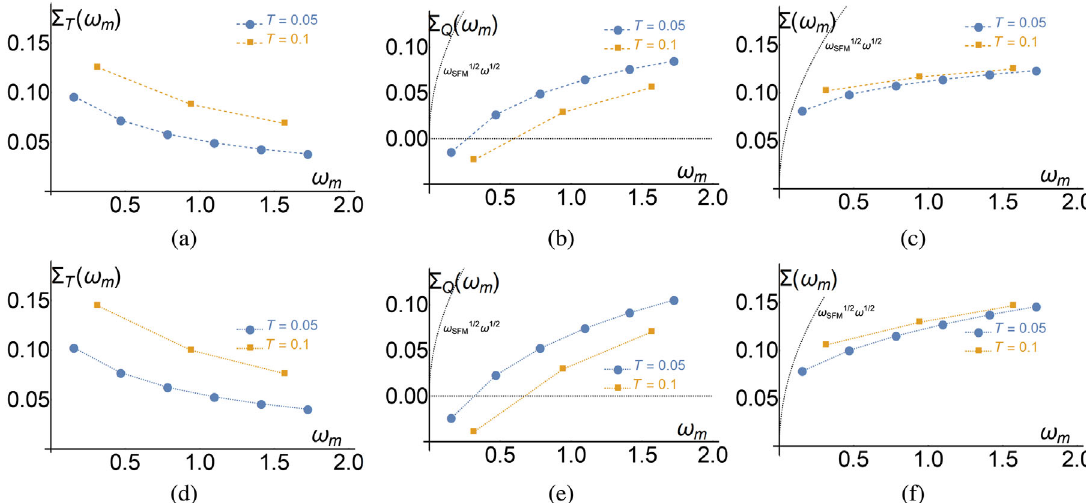
FIG. 5. Fermionic self-energy for the spin-fermion model. (a) – (c) Dashed traces: Fermionic self-energy from MET, Eq. (24), showing the (a) thermal, (b) quantum, and (c) total self-energy. The black dashed line on the right is the asymptotic T ¼ 0 prediction of ET. (d) – (f) Dotted traces: Fermionic self-energy from LT.